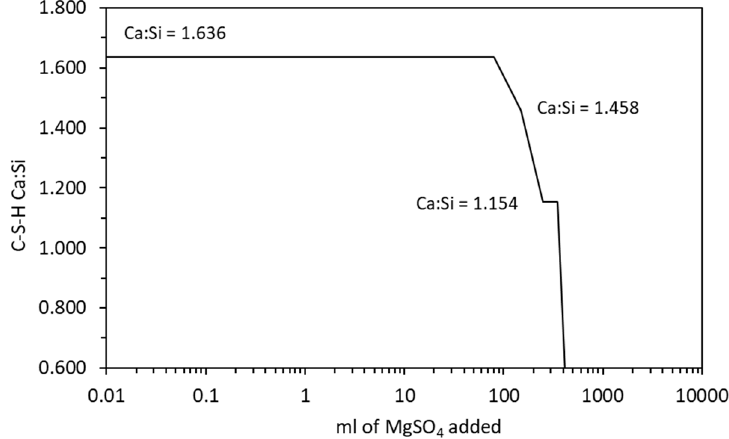
Figure 10. Change in the C-S-H Ca:Si ratio with increasing magnesium sulfate exposure.